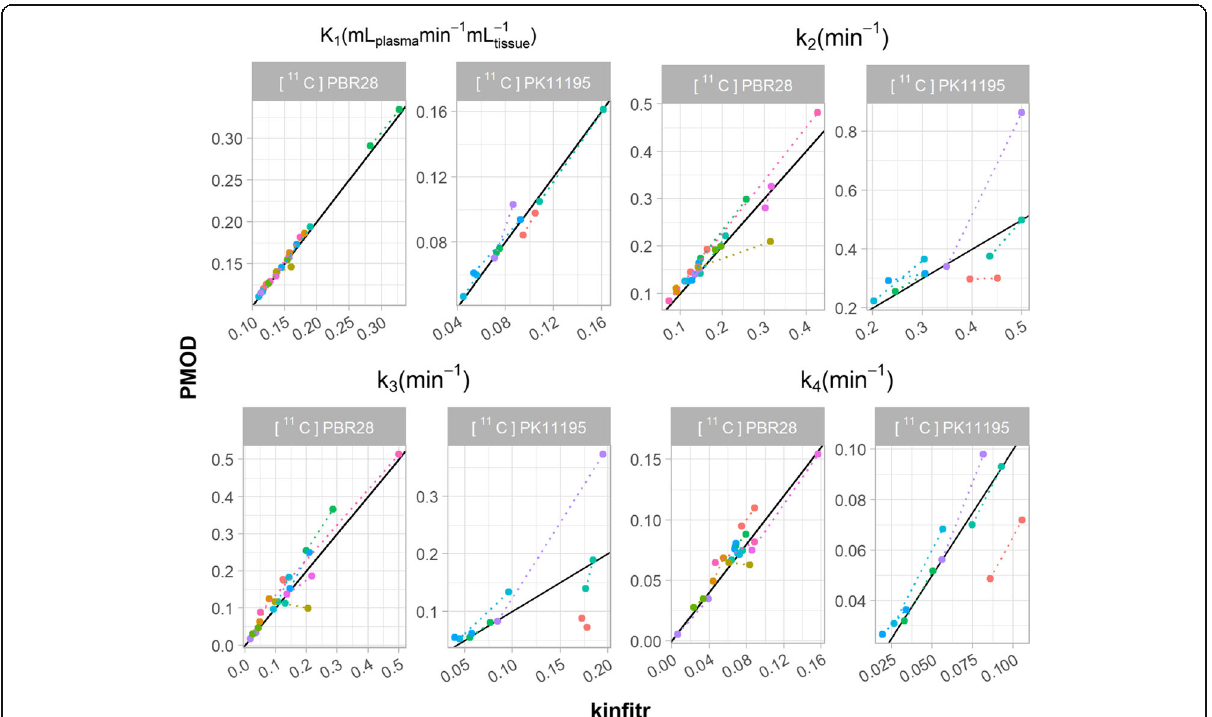
Fig. 4 Microparameter comparison for the two-tissue compartment model (2TCM). The relationship between the values of individual rate constants calculated by either kinfitr or PMOD. All results were derived from the thalamus region. The diagonal line represents the line of identity. Each colour corresponds to a different subject, and the dotted lines connect both measurements from the same